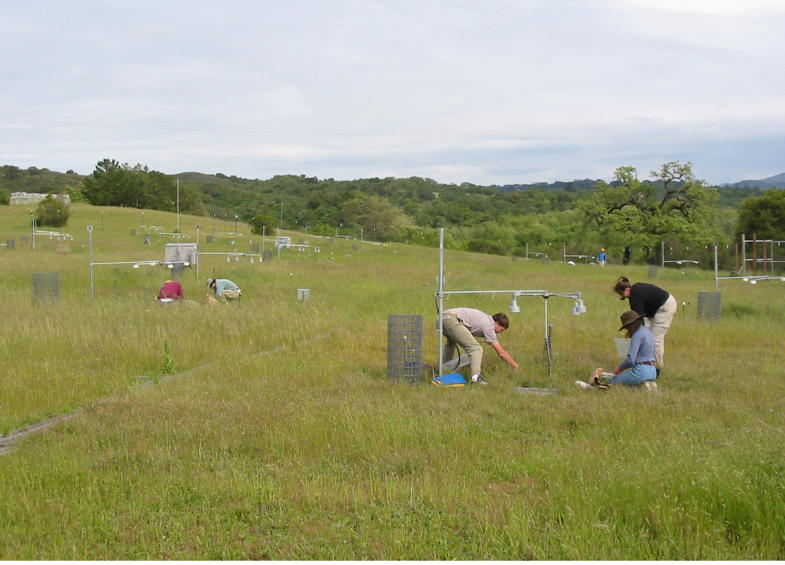
Researchers work on some of the 36 plots that lie below four infrared heaters in the Jasper Ridge Global Change Experiment. Total plant growth in grassland plots like these rarely responded to changes in climate or atmospheric CO2 concentration